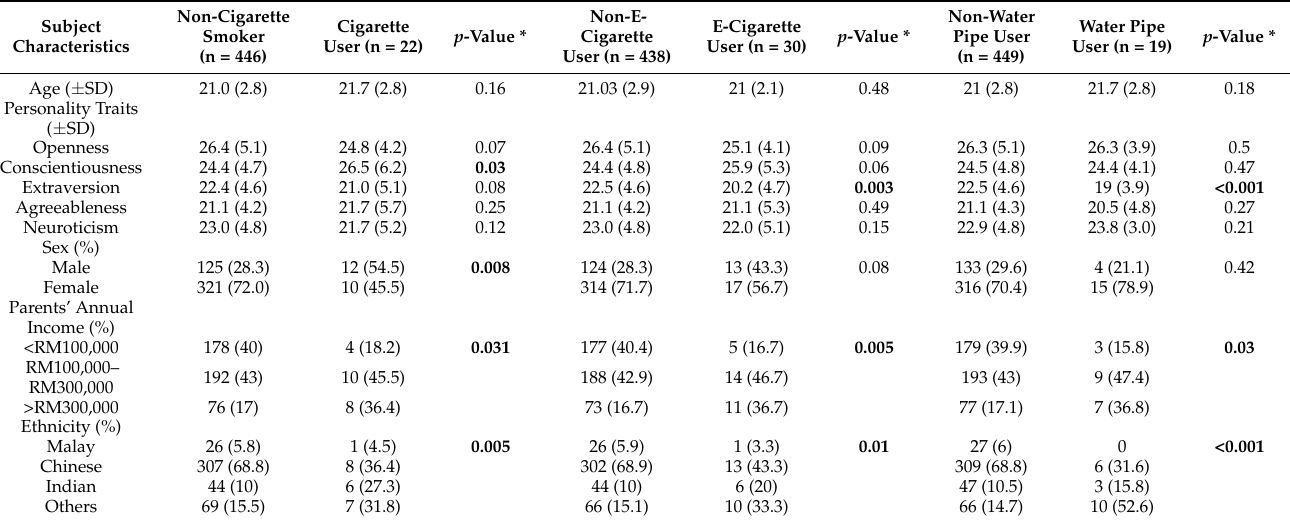
Table 4. Comparison of subject characteristics between tobacco product type users and non-smoking tobacco product type users.